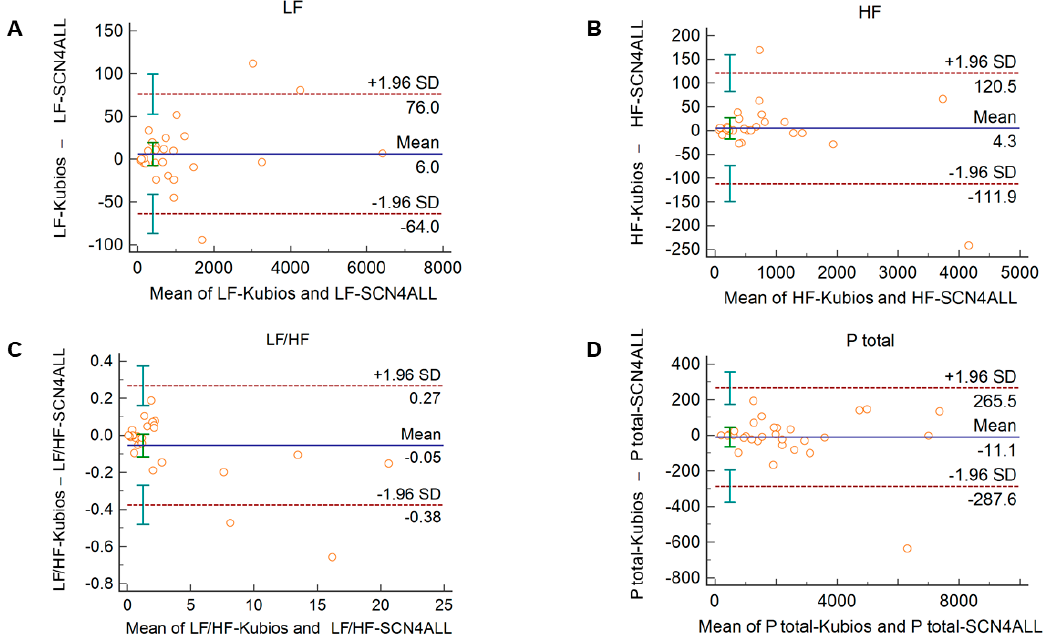
Figure 4. Bland–Altman plots of frequency-domain HRV/PRV parameters calculated by the SCN4ALL (indicated as ‘parameter name-SCN4ALL’) and the Kubios Premium HRV (indicated as ‘parameter name-Kubios’) algorithms from 2-min long PPG recordings captured under resting conditions. ( A ) Ptotal (total spectral power), ( B ) LF/HF (ratio of low frequency to high frequency), ( C ) LF (absolute power of the low-frequency band (0.04–0.15 Hz)), ( D ) HF (absolute power of the high-frequency band (0.15–0.4 Hz)). Bias is calculated as the mean of differences (indicated as ‘Mean’—blue solid line) and is presented with 95% confidence intervals (green) and +/ − 1.96 standard deviations (SD) and their confidence intervals.